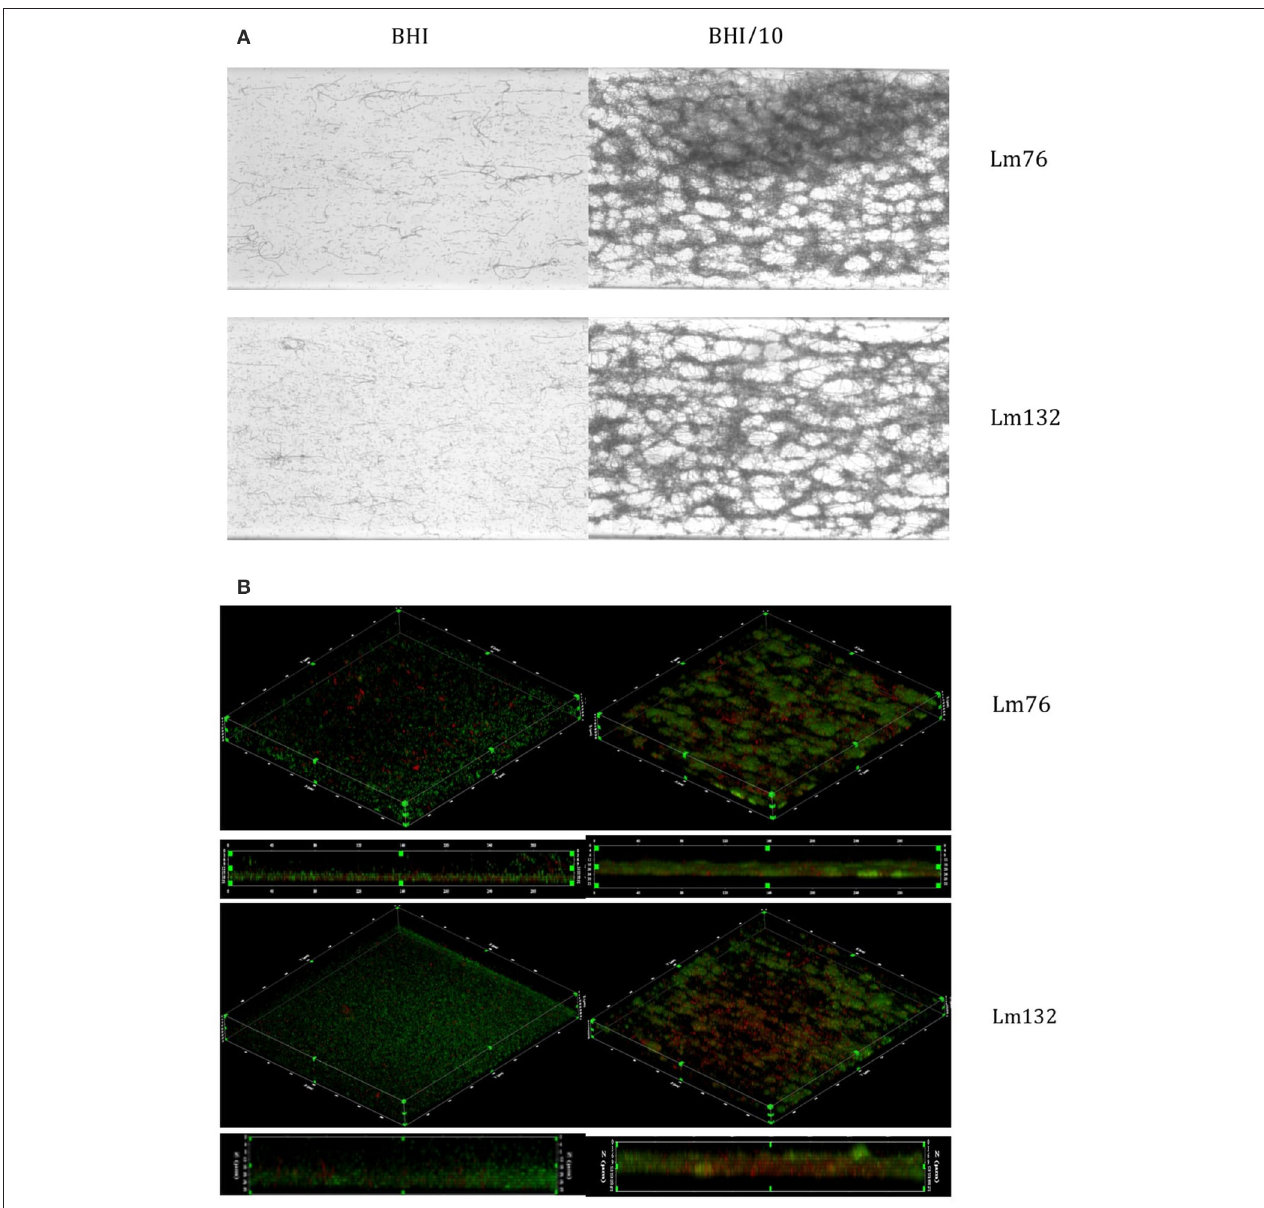
FIGURE 1 | Biofilm visualization of two strains of Listeria monocytogenes —Lm76 and Lm132—after 24 h of incubation at 30 ◦ C in microfluidic conditions. Biofilm was grown in BHI medium (left images) and BHI/10 (right images); (A) Biofilm stained with Crystal violet 0.1% (B) 3D reconstruction of L. monocytogenes biofilm stained with live/dead; Syto9 showing live cells in green and Propidium iodide showing dead/damaged cells and e-DNA in red (B) .